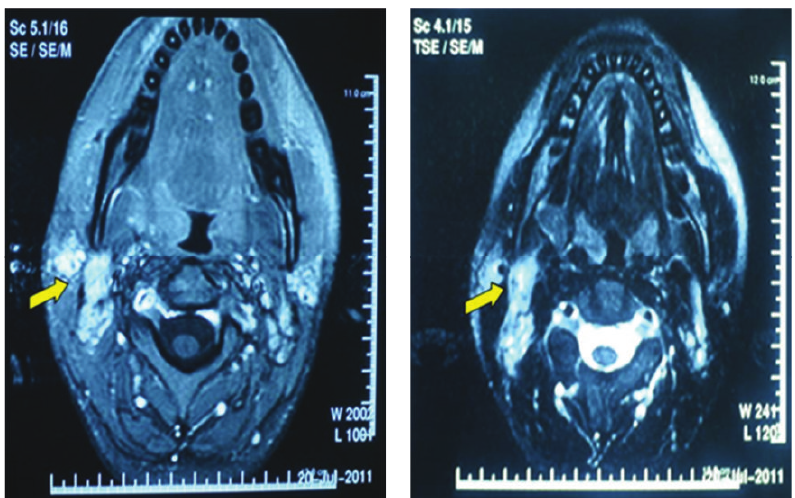
Figure 1: T1- and T2-weighted MR images showing right-sided cervical lymphadenopathy with focal hypointense areas with peripheral distribution and clear margins.